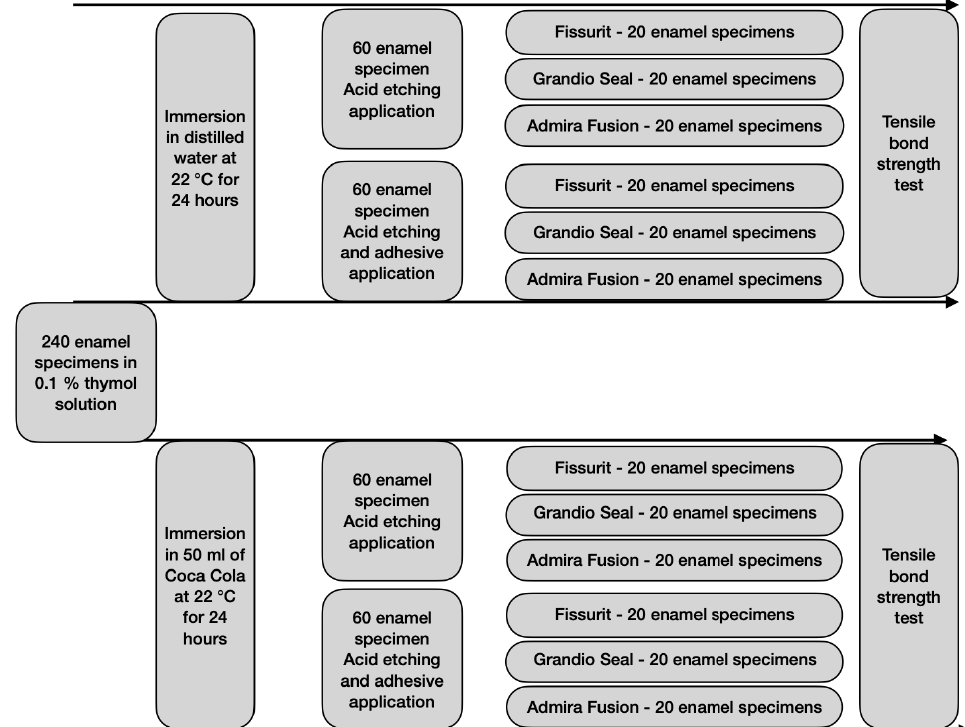
Figure 1. Flow chart of the grouping and testing